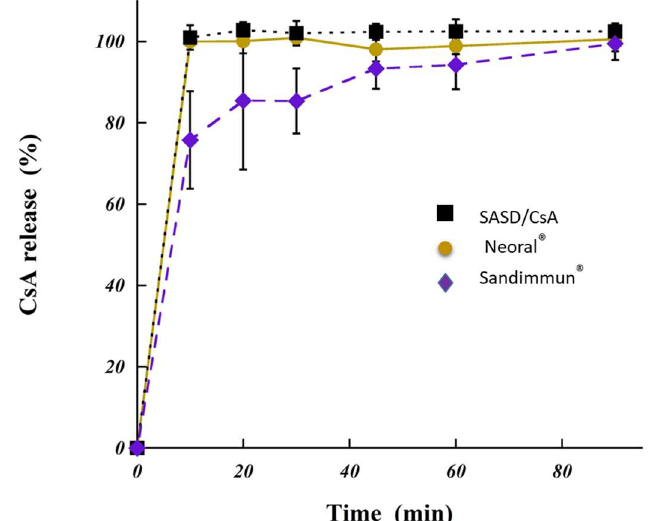
Figure 5. In vitro dissolution of cyclosporine A (CsA) from spherical amorphous solid dispersion based on Poly- αβ -CD polymer (SASD/CsA) under conditions simulating the gastric fluid. The point at zero minute is theoretical. For reasons of comparison, two different commercially available products under conditions simulating the gastric fluid are shown; Neoral ® and Sandimmun ®.